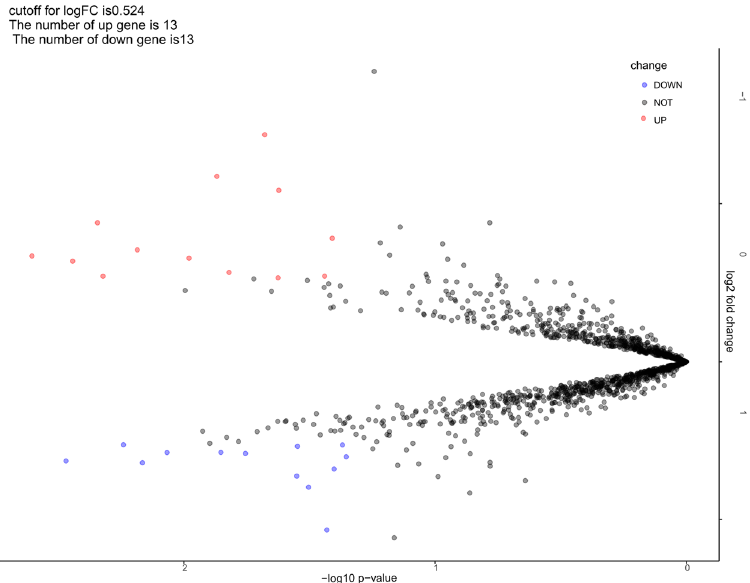
Figure 3. Volcano map of DEMis. Up-regulated genes are represented by red spots while down-regulated genes by blue spots.